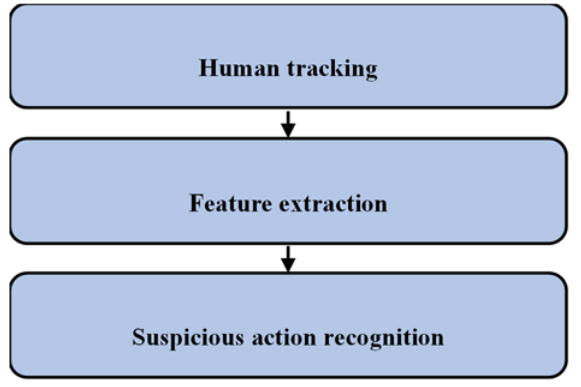
Figure 1. Overview of suspicious ‐ action detection .